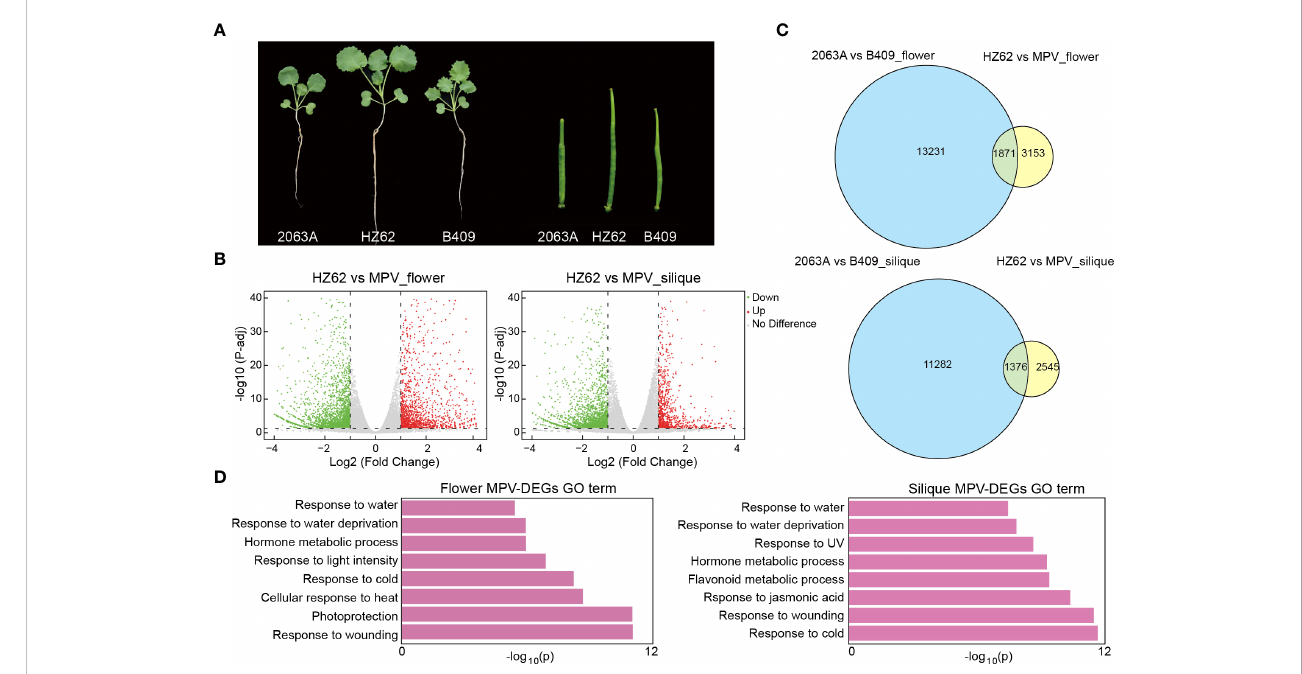
FIGURE 1 Differentially expressed genes (DEGs) in hybrid compared with MPVs (mid-parent values). (A) Phenotypic difference and heterosis in the seedling (2- week-old plants) and silique (10 days after pollination) tissues of hybrid. (B) Volcano plot of MPV-DEGs in fl ower bud and silique tissues of hybrid [false discovery rate <0.05, log2 (fold change) > 1 or < – 1]. (C) Overlap of DEGs between parents and MPV-DEGs in fl ower bud. (D) GO terms were associated with MPV-DEGs in the indicated